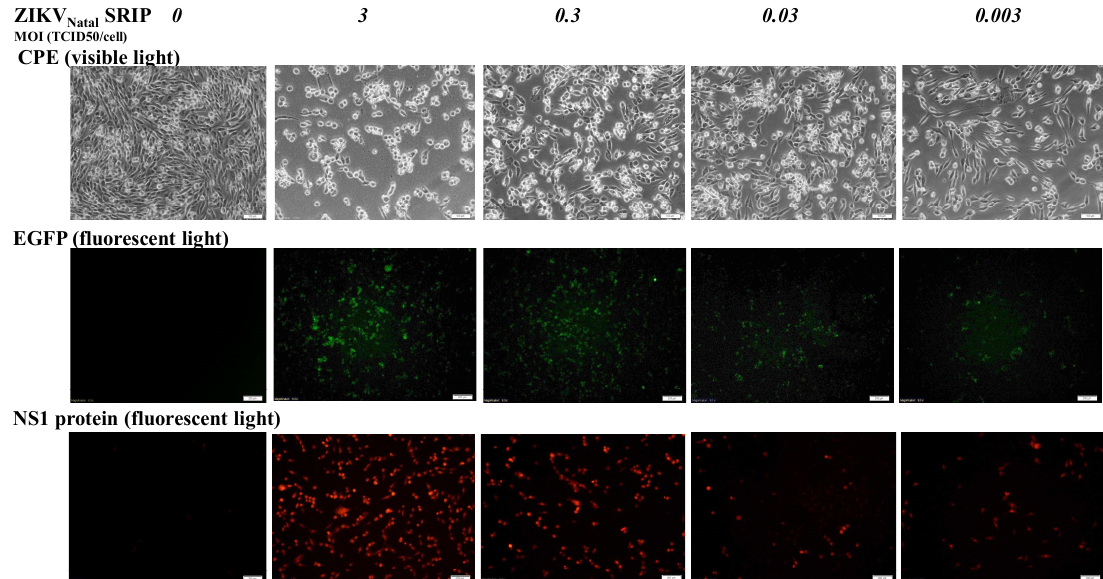
Figure 5. Infectivity of ZIKV Natal RGN SRIPs in prM-E-expressing packaging cells. The cells were infected with ZIKV Natal RGN SRIPs at MOIs of 3, 0.3, 0.03, and 0.003. The cytopathic effect (top) and the EGFP reporter (middle) in SRIP-infected cells were photographed using light and fluorescence microscopy 72 h post-infection. In addition, infected cells were washed, fixed, and stained by anti-NS1 antibodies and Alexa Fluor 546-conjugated secondary antibodies (bottom). Finally, cell imaging was taken by immunofluorescence microscopy. Scale bars, 100 µ m for CPE and EGFP images (top and middle) and 200 µ m for the NS1 image.